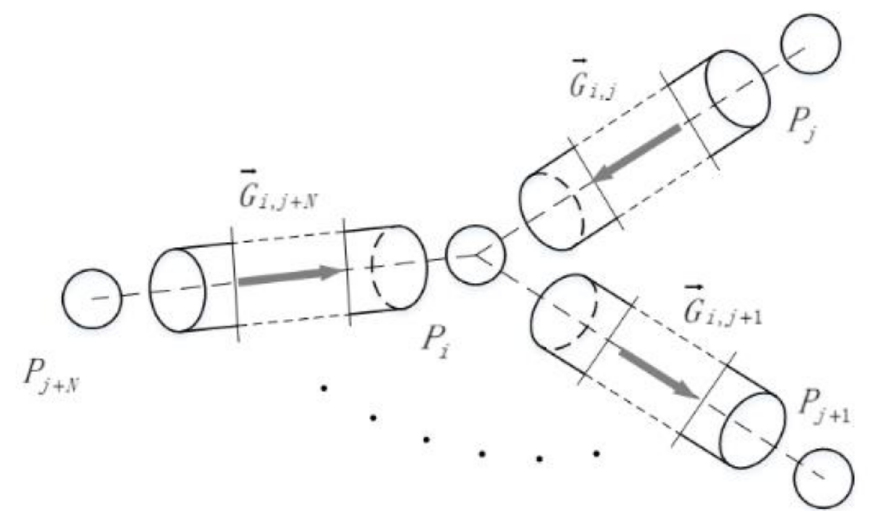
Figure 2. Schematic diagram of the topological structure of the i -th node of the pipeline. P is the pressure at node i . G ij is the flow rate between node i and node j